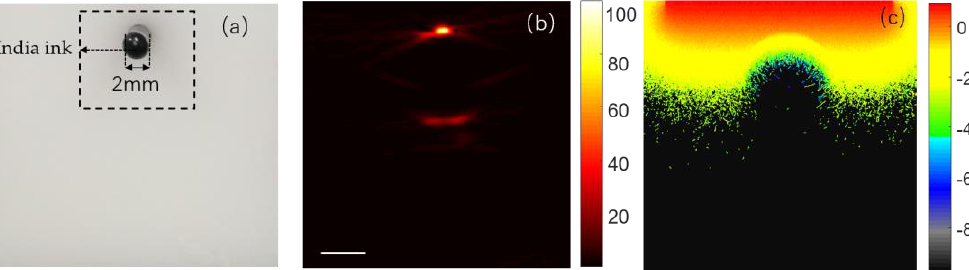
Figure 7. ( a ) the configuration of phantom; ( b ) a B-scan of phantom PA signal, the color scale (right) represents the absorbed energy density; ( c ). A caption on a single line should be centered, the color scale (right) unit is J/cm 2 . The scale bar (short solid white line) is 1 mm. A-line profiles are selected to visualize the iteration recovery results, and the recovery results of absorption coefficients of the 3rd, 6th and 13th iterations are shown in Figure 8a – c, respectively. After 13 iterations, the condition of iteration stopping was reached and the optimal quantitative estimate value could be outputted. The results show that the proposed algorithm can effectively reduce or even eliminate the influence of light fluence on the measured absorption distribution.